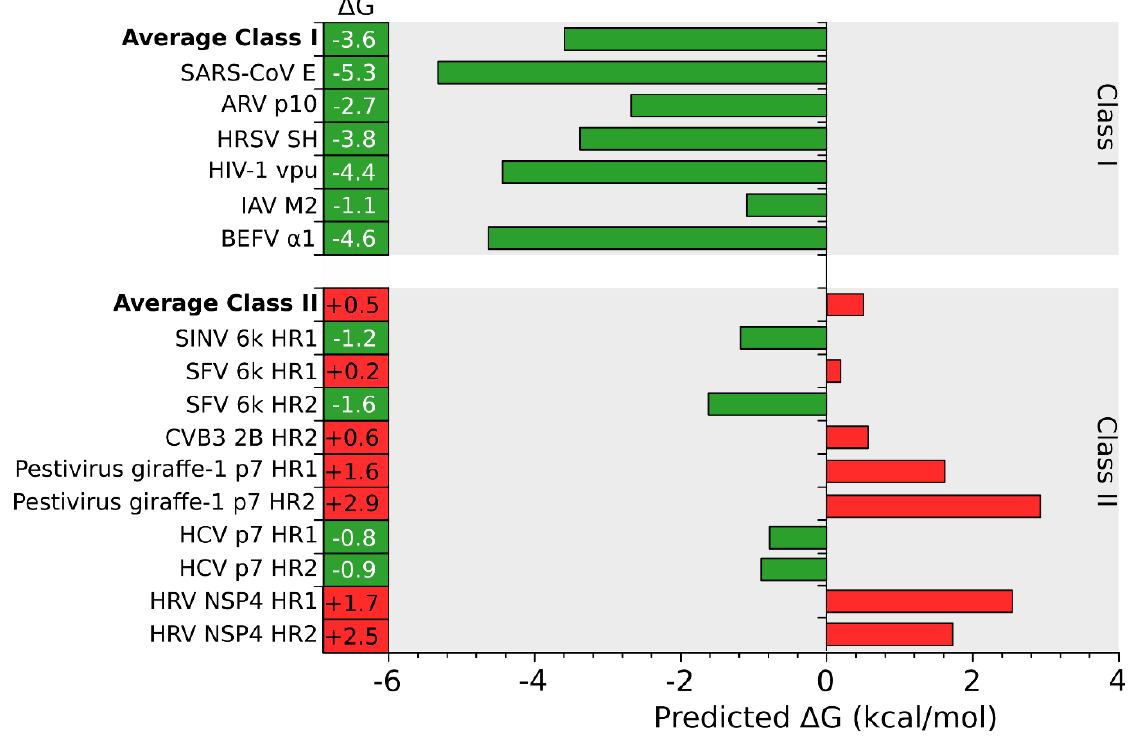
Figure 3. In silico prediction of putative TM segments. An analysis of the putative TM segments of Class I (top) and II (bottom) viroporins was done using the ∆ G Prediction Server [13]. The figure shows the predicted ∆ G (kcal/mol) for each putative TM segment and the average ∆ G for Class I and II viroporins. Green and red bars indicate negative and positive ∆ G values respectively. BEFV Bovine ephemeral fever virus, IAV Influenza A virus, HIV Human immunodeficiency virus, HRSV Human respiratory syncytial virus, ARV Avian reovirus, SARS-CoV Severe acute respiratory syndrome Corona virus, PV1 Poliovirus 1, HCV Hepatitis C virus, CVB3 Coxsackievirus B3, SFV Semliki forest virus, SINV Sindbis virus, HRV Human rotavirus A.